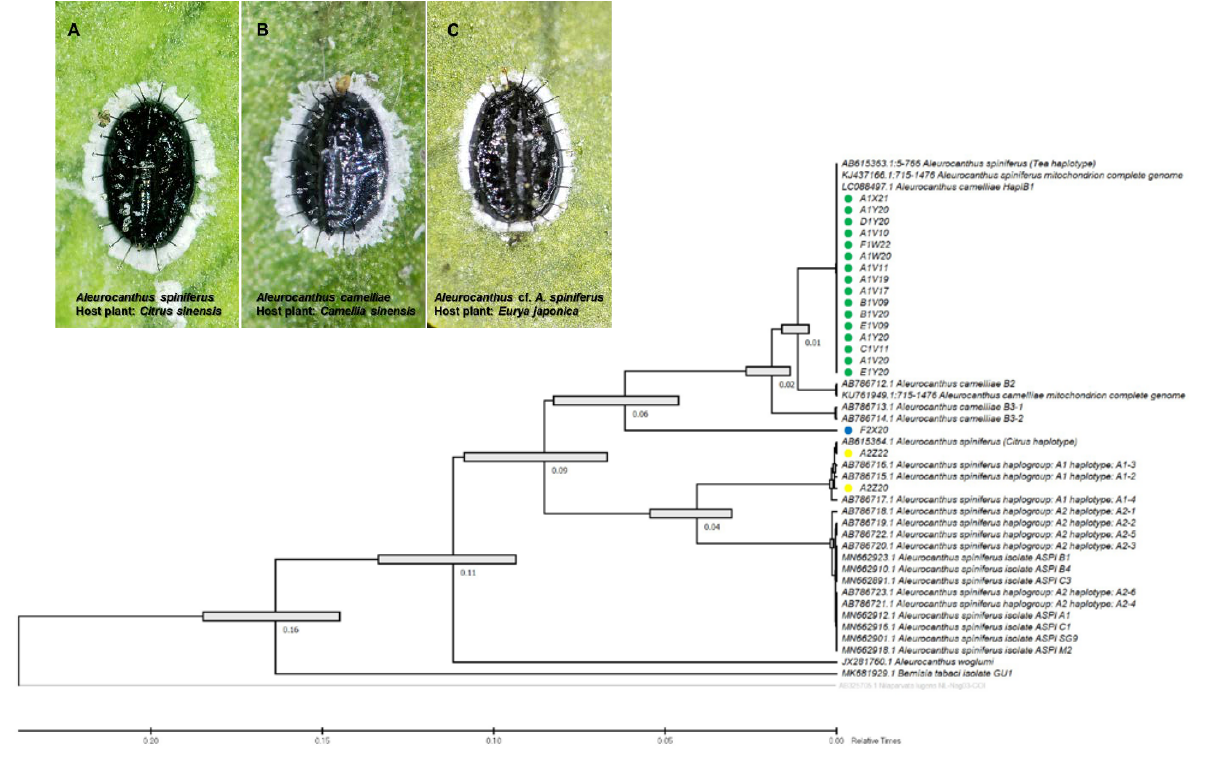
Figure 2. Evolutionary analysis via maximum likelihood method (timetree) based on the partial sequence mitochondrial COI (COI-2) gene of the A. camelliae cryptic species complex. Yellow circles are isolates of the A. spiniferus haplogroup A1 ( A ); green circle isolates are the A. camelliae haplotype B1 ( B ); and the blue circle is an isolate of the Aleurocanthus cf. A. spiniferus ( C ). Nodes with error bars were indicated in grey bars. Nilaparvata lugens (no. AB325705.1) were assigned as an outgroup. The evolutionary time was predicted by the relative time (Rt) scale bar. Table 2. Identification of mitochondrial genes using BLAST and the Wolbachia infection status.